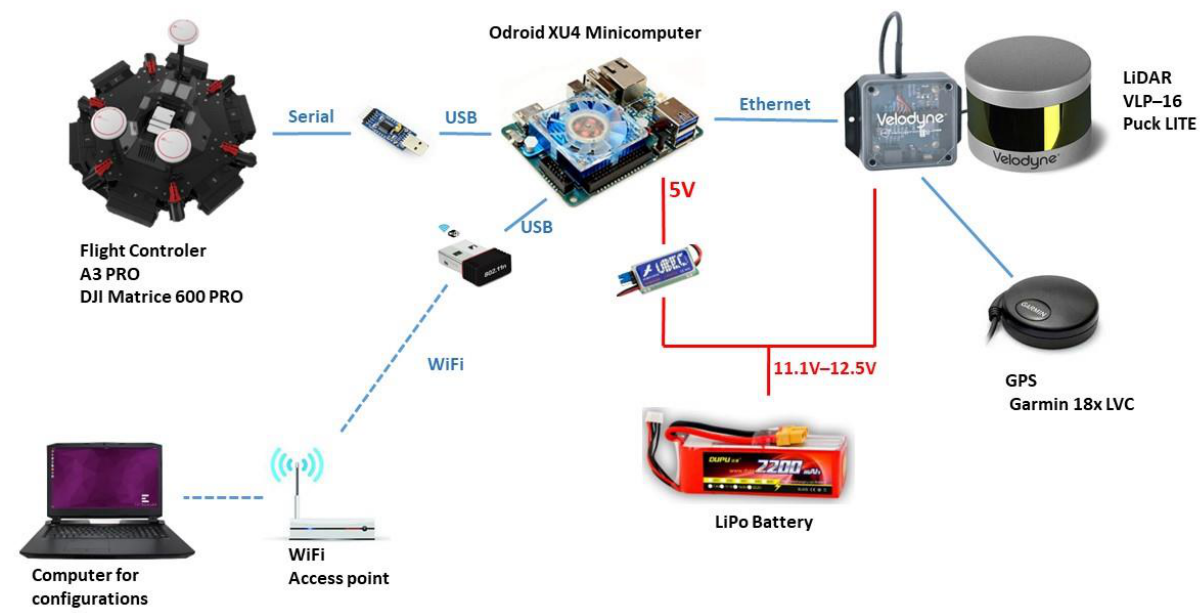
Figure 1. Integration scheme developed for the LiDAR system. Table 1. Equipment specifications.